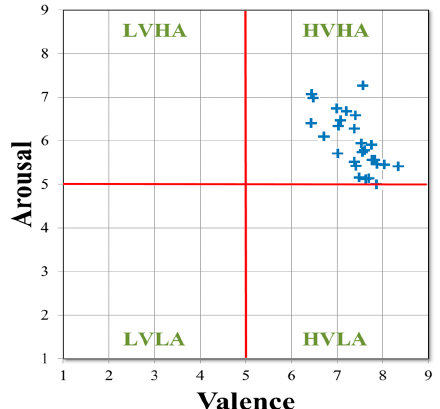
Figure 1. Distribution of the valence and arousal scores of the selected 27 International Affective Picture System (IAPS) pictures. Every picture has valence and arousal scores higher than five. LVHA = low valence, high arousal; HVHA = high valence, high arousal; LVLA = low valence, low arousal; and HVLA = high valence, low arousal.